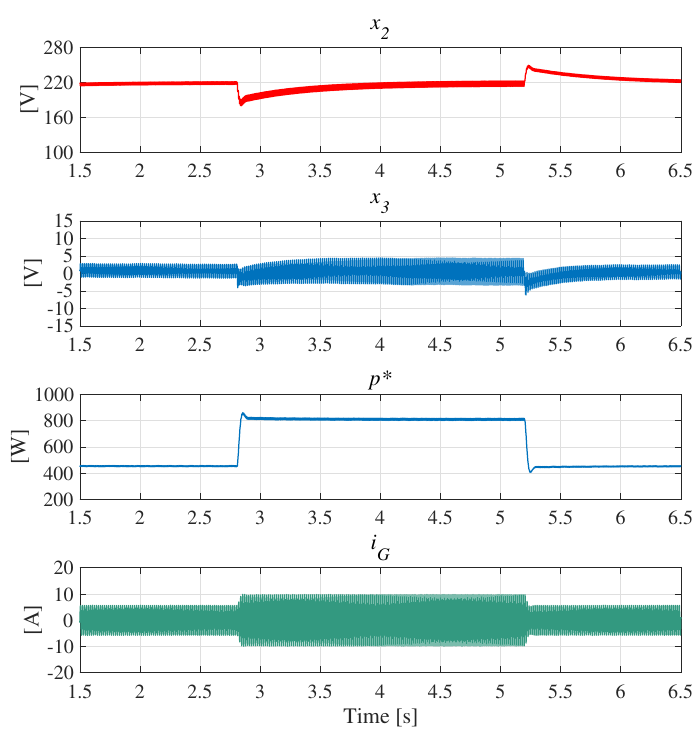
Figure 8. Transient responses of the sum of the capacitors voltages x 2 , the difference of the capacitors voltages x 3 , the power reference p ∗ , and the line current i G during a load change.